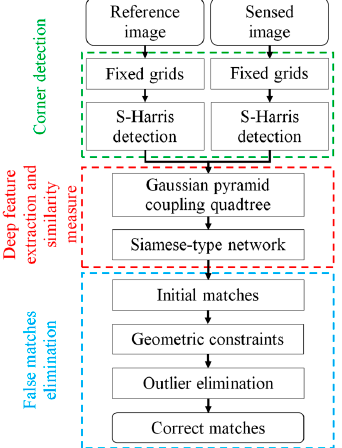
Figure 2. Schematic of the proposed matching framework.